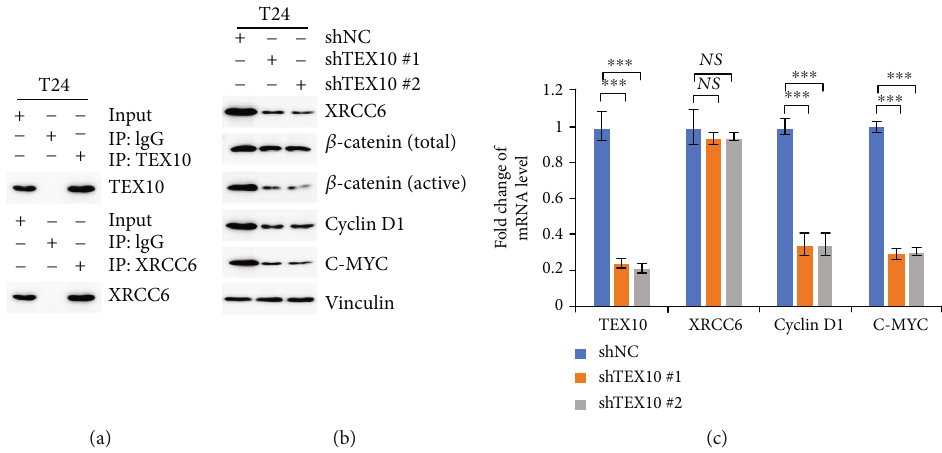
Figure 5: TEX10 regulates the level of XRCC6 and its downstream. (a) T24 cells were performed for immunoprecipitation with the TEX10 or XRCC6 antibodies, followed with immunoblot with suggested antibodies. (b) T24 cells with the steady expression of shNC, shTEX10 #1, and shTEX10 #2 underwent immunoblot using the suggested antibodies. (c) T24 cells with the steady expression of shNC, shTEX10 #1, and shTEX10 #2 underwent analyses by real-time PCR. Shown is the mean ± SEM . ∗ P < 0 : 05 ; ∗∗ < 0.01; ∗∗∗ < 0.001, Student ’ s t